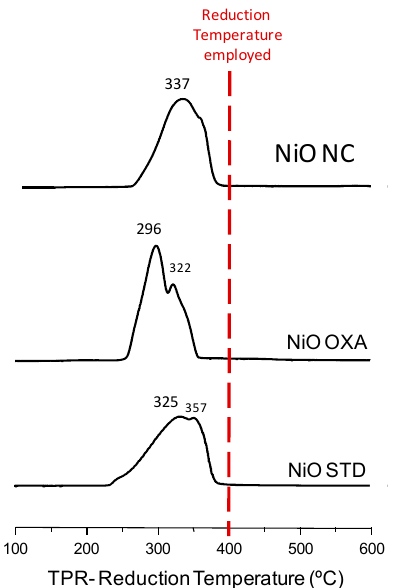
Figure 5. Temperature programmed reduction of nickel oxide precursors prepared by different preparation procedures.